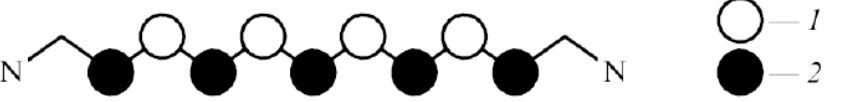
7 of 28 Figure 2. Shapes of optical absorption bands and Egorov nano-resonance ( n = 3) in a series of polymethine dyes with varying lengths of polymethine chain L = 2 ( n + 2) d , where d are certain roughly equal bond lengths (0.14 nm) in the chain (thiapolymethinecyanine in methanol at room temperature; ε is the extinction coefficient) [7,8]. ( a ) Experimental data [35,36] and ( b ) theoretical modeling [24,37] based on quantum–classical mechanics [5]. (Original citation)—Reproduced by